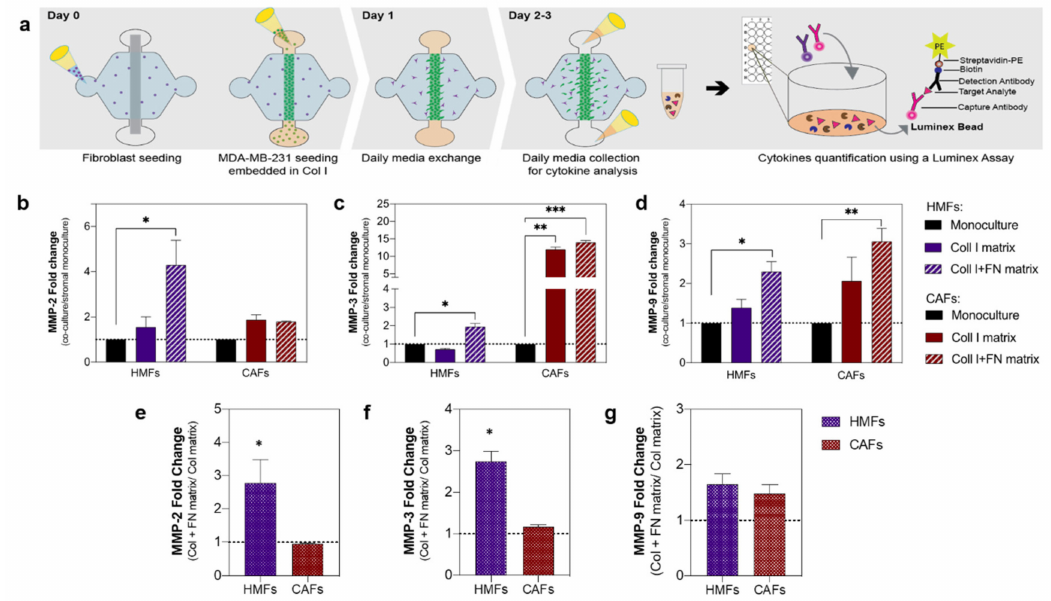
Figure 3. Influence of ECM protein and fibroblast composition on MMPs secretion. ( a ) Schematic of the process. Metalloproteinases (MMP) concentration for the di ff erent microenvironments was determined via a multiplex bead-based ELISA. ( b – d ) MMPs fold change in co-culture with HMFs (purple bars) and CAFs (red) within a collagen matrix (solid bar) and a fibronectin-rich matrix (striped bar) fibroblast monoculture showed in solid black. ( b ) MMP-2-fold change. ( c ) MMP-3-fold change. ( d ) MMP-9-fold change. ( e – g ) MMP fold increase in the fibronectin-rich matrix compared to the collagen-only matrix for the co-culture with HMFs (patterned purple) and CAFs (patterned red) (e) MMP-2- ( f ) MMP-3- (g) MMP-9. Bars represent average ± SD, n = at least four individual devices. * p ≤ 0.05, ** p ≤ 0.01, *** p <